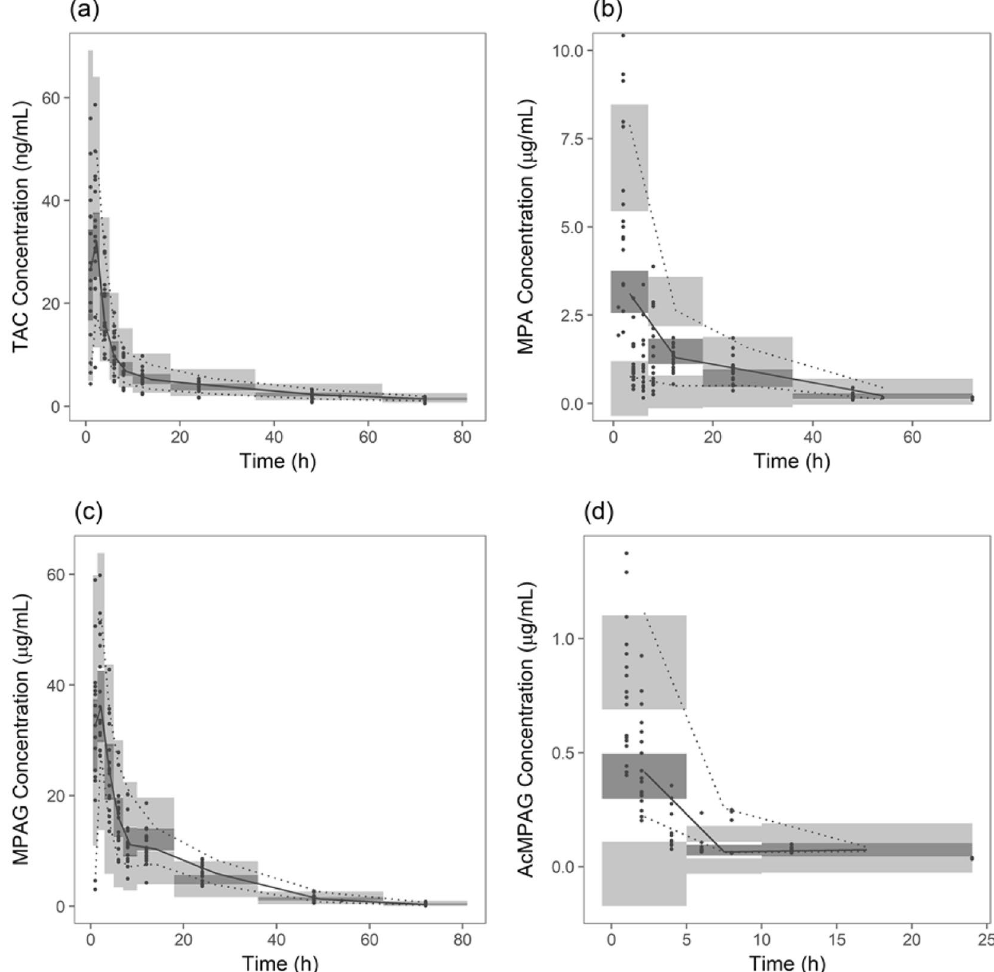
Figure 2. Visual predictive check of integrated population pharmacokinetic models. ( a ) TAC; ( b ) MPA; ( c ) MPAG; ( d ) AcMPAG. Closed circles represent observed concentrations. Solid line represents median of observed concentration and dotted line represents 5 th and 95 th percentile of observed concentration. Light grey area represents 95% confidence interval of 5 th and 95 th percentile of predicted concentration and dark grey area, 95% confidence interval of median of predicted concentration. TAC, tacrolimus; MPA, mycophenolic acid; MPAG, MPA 7-O-glucuronide; AcMPAG, MPA acyl